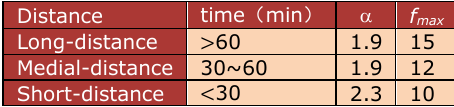
Table 1. Parameter Value of Different